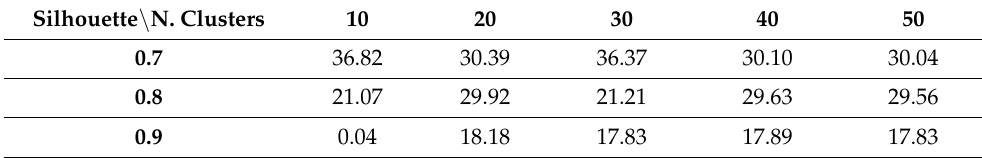
Table 22. Clustering performance in terms of silhouettes using normalized data. Silhouette \ N. Clusters